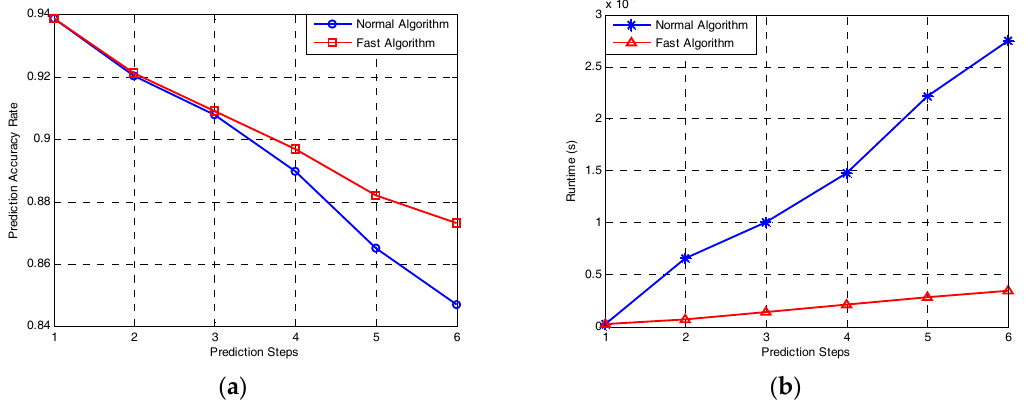
Figure 6. Prediction accuracy and efficiency of the normal algorithm and fast algorithm. ( a ) Prediction rate versus the number of prediction steps; and ( b ) runtime versus the number of prediction steps.